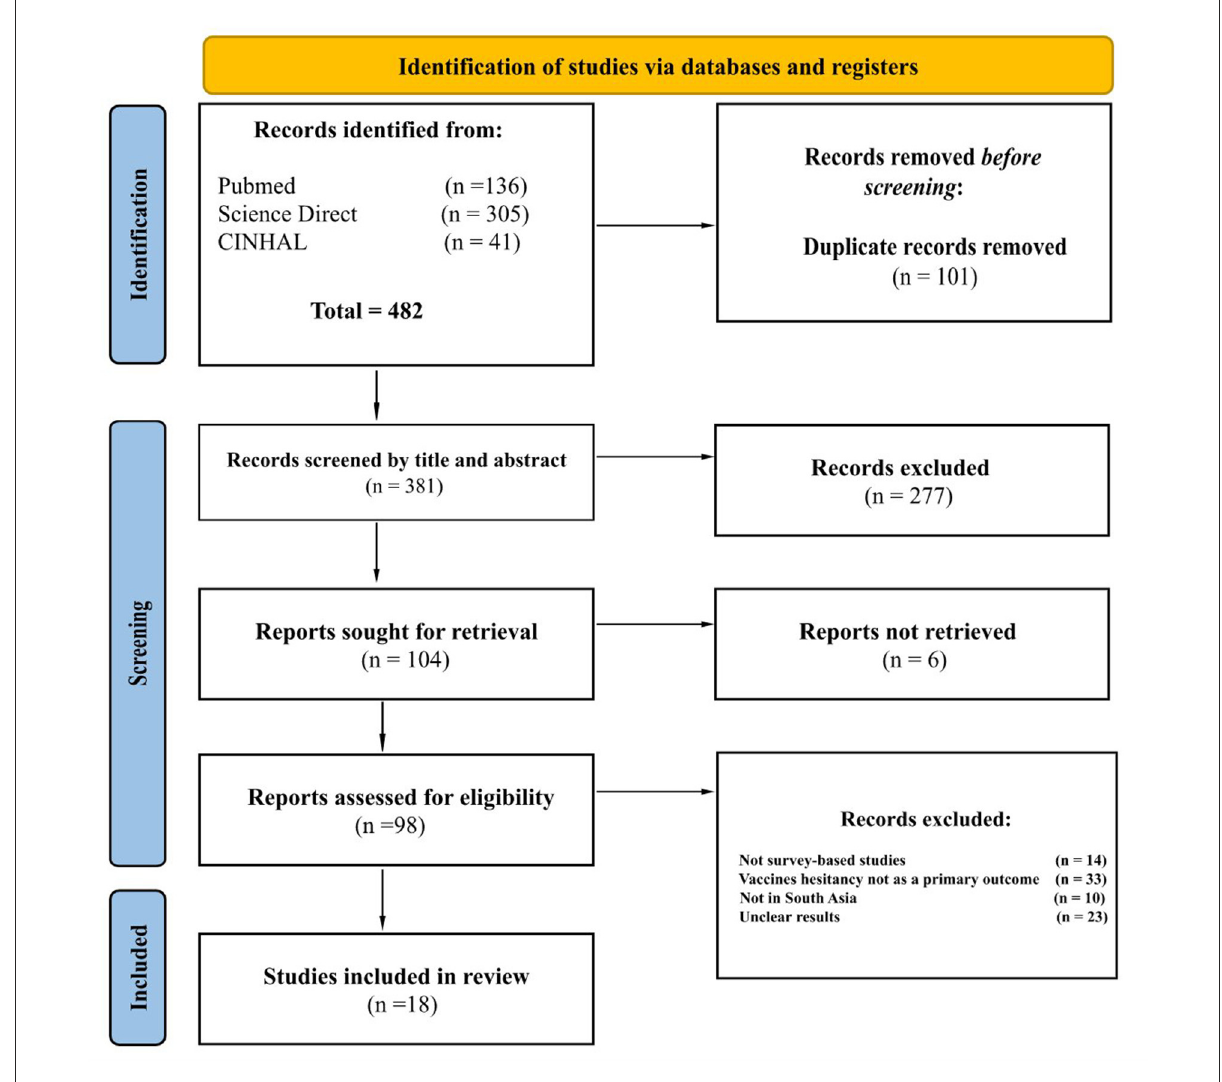
FIGURE1 PRISMA flow diagram highlighting the selection process of the final studies included in this narrative